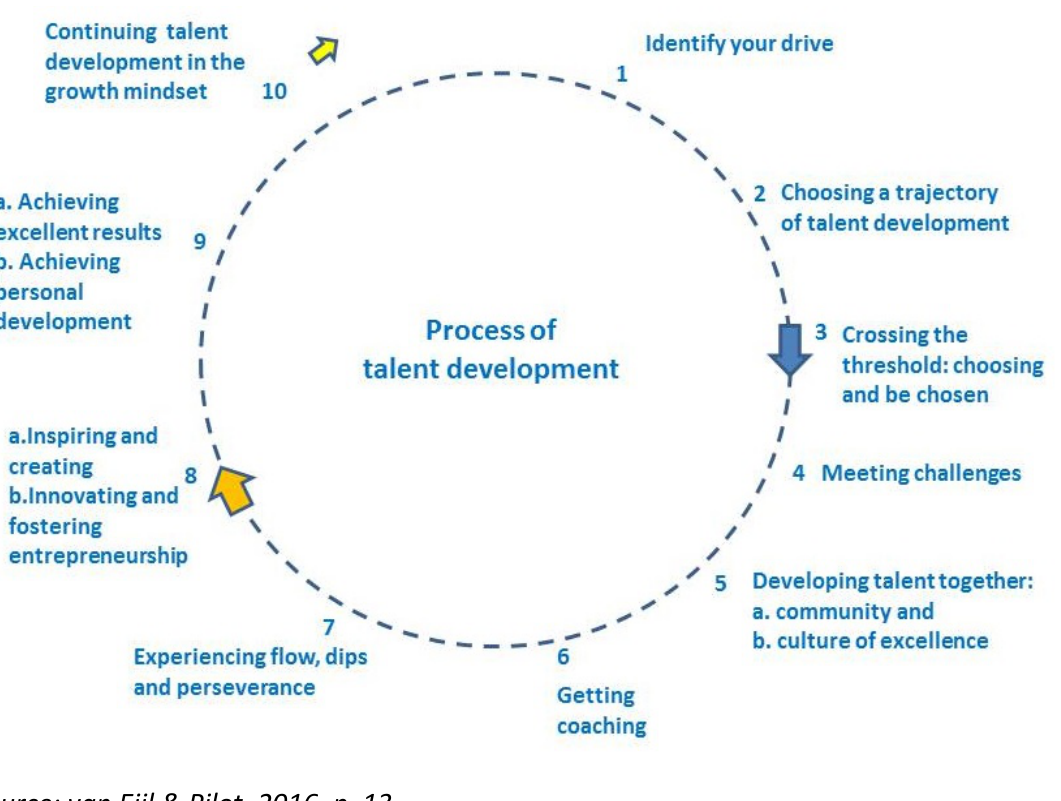
Source: van Eijl & Pilot, 2016, p.